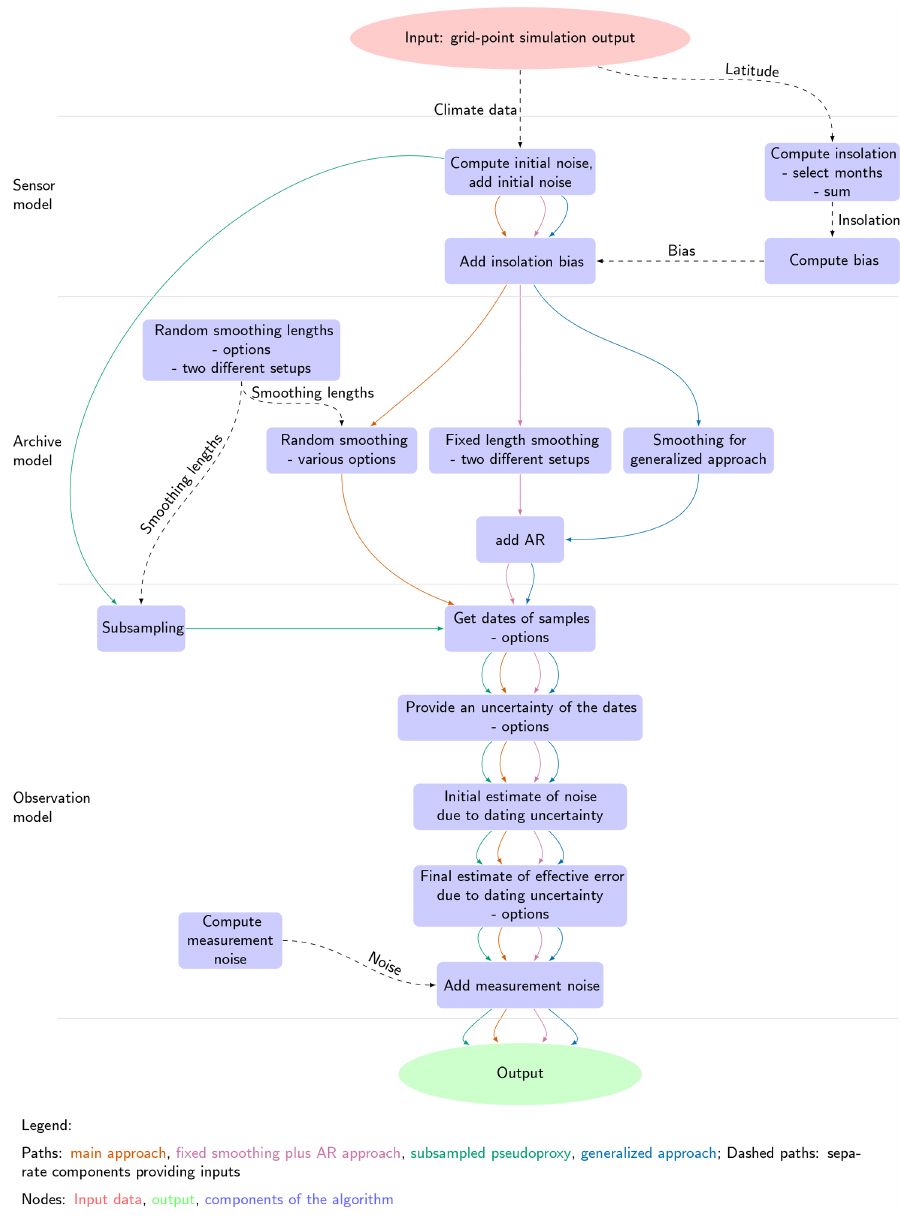
Figure 1. Conceptual flow of the